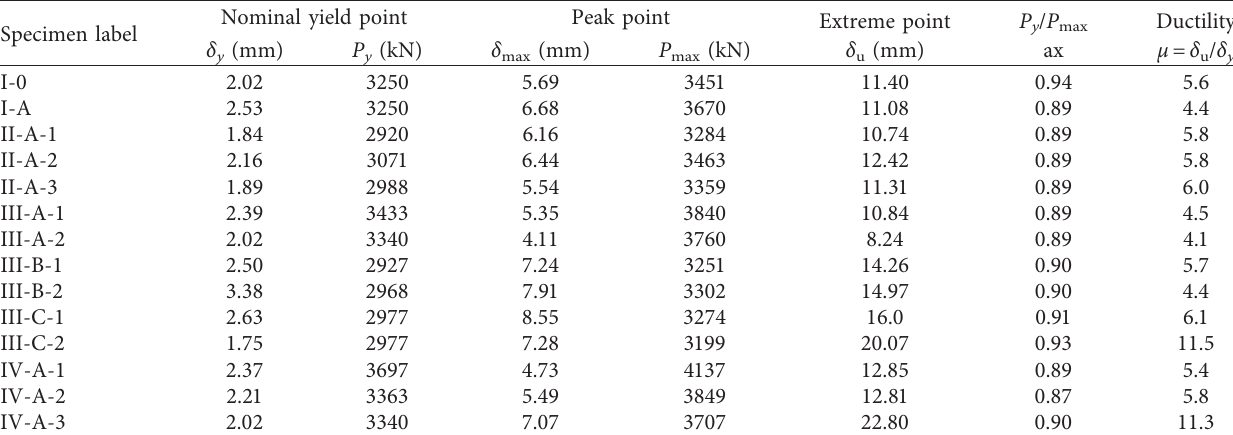
Figure 11: Effects of height of constrained LYP steel tubular plate. Table 3: Summary results of axially compressed